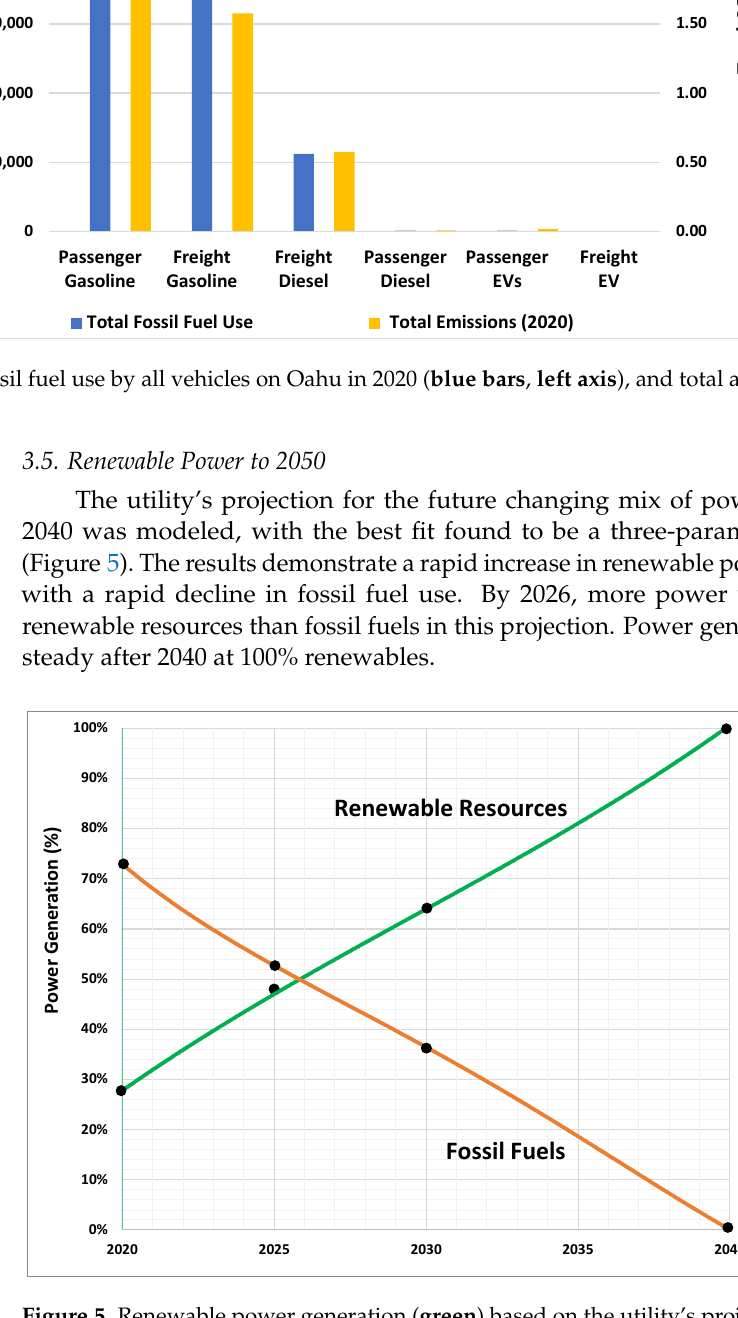
Figure 5. Renewable power generation ( green ) based on the utility’s projection to replace fossil fuel ( orange ) through 2040. (Black markers show the data points used to generate the curve.).